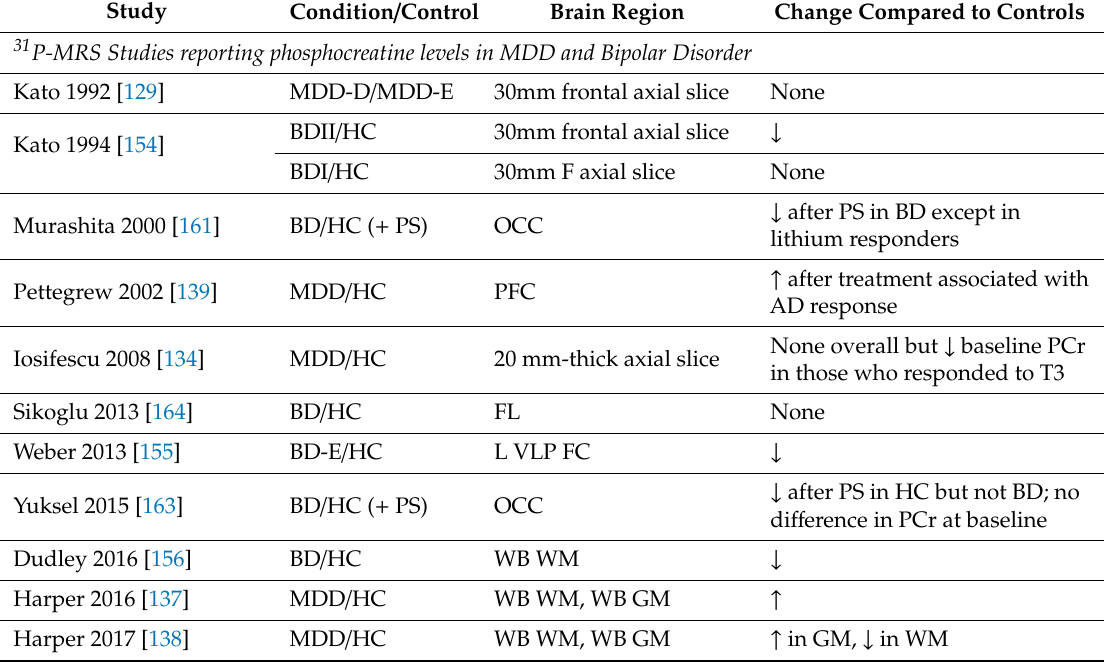
Table 1. Studies reporting phosphocreatine and total creatine levels in major depressive disorder.